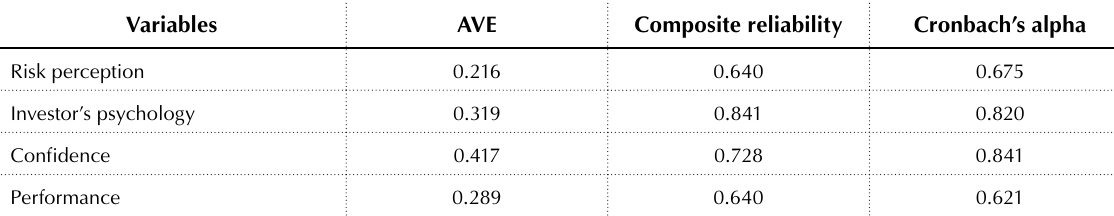
Table 8. The result of the test